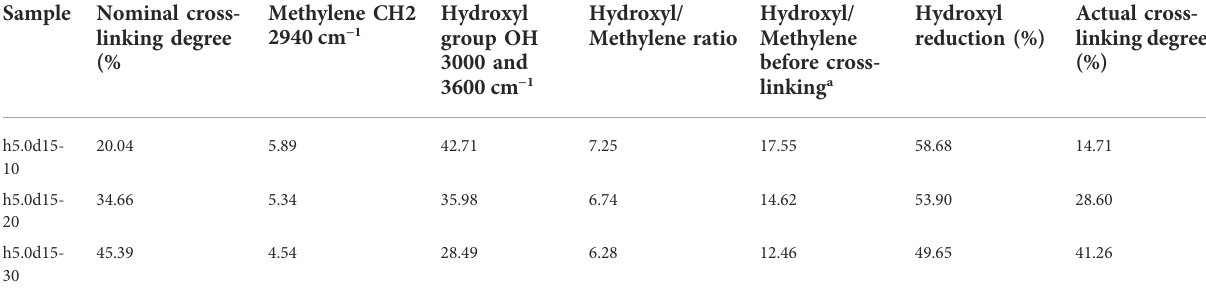
TABLE 1 Nominal cross-linking degree and actual cross-linking degree of h5.0d15-z. Sample